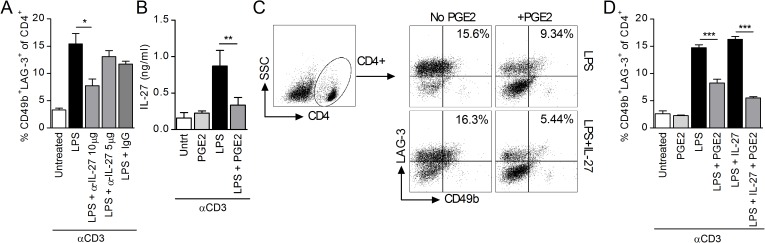
PGE2 inhibits Tr1 cell differentiation in splenocyte cultures.(A) il10gfp splenocytes were stimulated with 3 μg/ml anti-CD3 and 1 μg LPS in the presence of neutralizing IL-27 antibodies (5 and 10 μg/ml) or IgG control (20 μg/ml). Cells were collected on day 3 and CD4+CD49b+LAG-3+ Tr1 cells were identified by FACS. Data are cumulative from two independent experiments. (B) Splenocytes were stimulated with anti-CD3 and LPS in the presence of PGE2 (10-6M). Supernatant was collected on day 3 and IL-27 levels analyzed by ELISA. (C-D) Splenocytes were stimulated with anti-CD3 and LPS in the presence or absence of IL-27 (50 ng/ml) and PGE2 (10-6M). Cells were collected on day 3 and CD4+CD49b+LAG-3+ Tr1 cells were identified by FACS. (C) Representative sample shows gating strategy to determine percentage of CD49b+LAG-3+ within CD4+ T cells and (D) graph presents representative data from three independent experiments. Each sample was tested in duplicate and results represent means ± SD. Significance was evaluated by one-way ANOVA; **P<0.01.